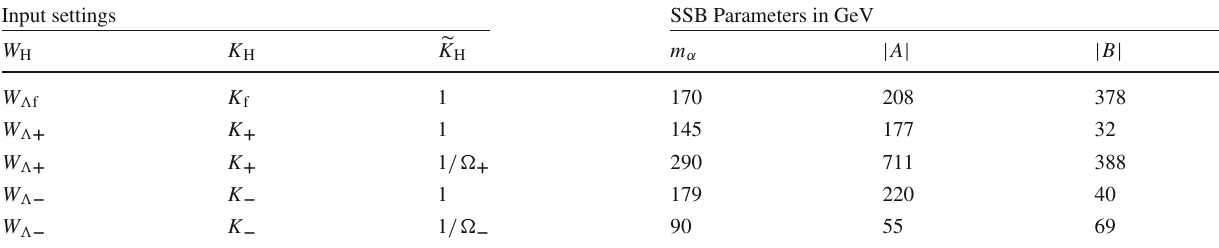
Table 2 SSB parameters: a case study for the inputs of Table 1 Input settings SSB Parameters in